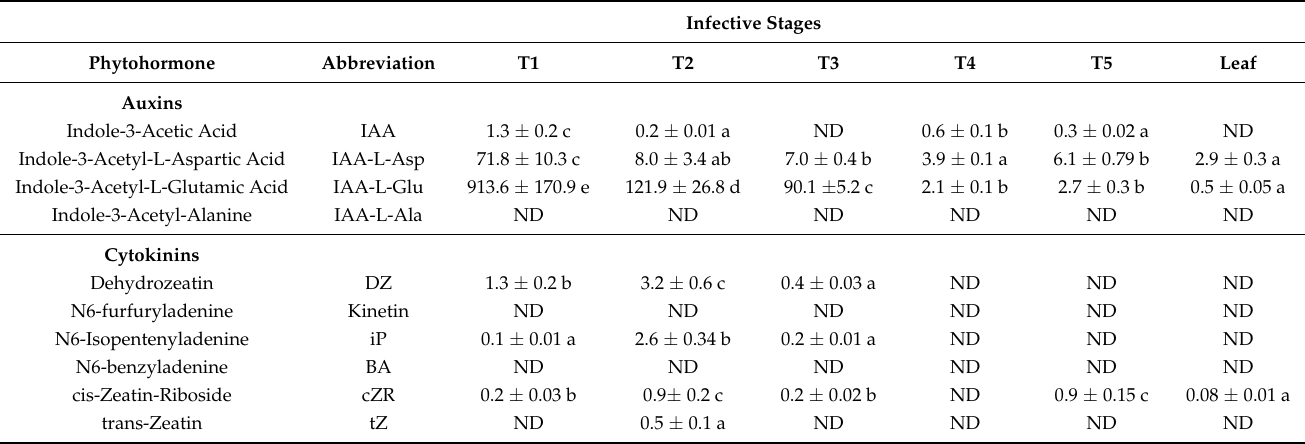
Table 2. Phytohormone level of Psittacanthus calyculatus during infective stages. Infective